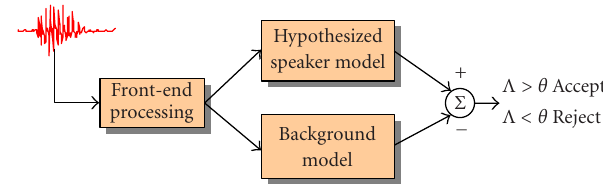
Figure 5: Likelihood-ratio-based speaker verification